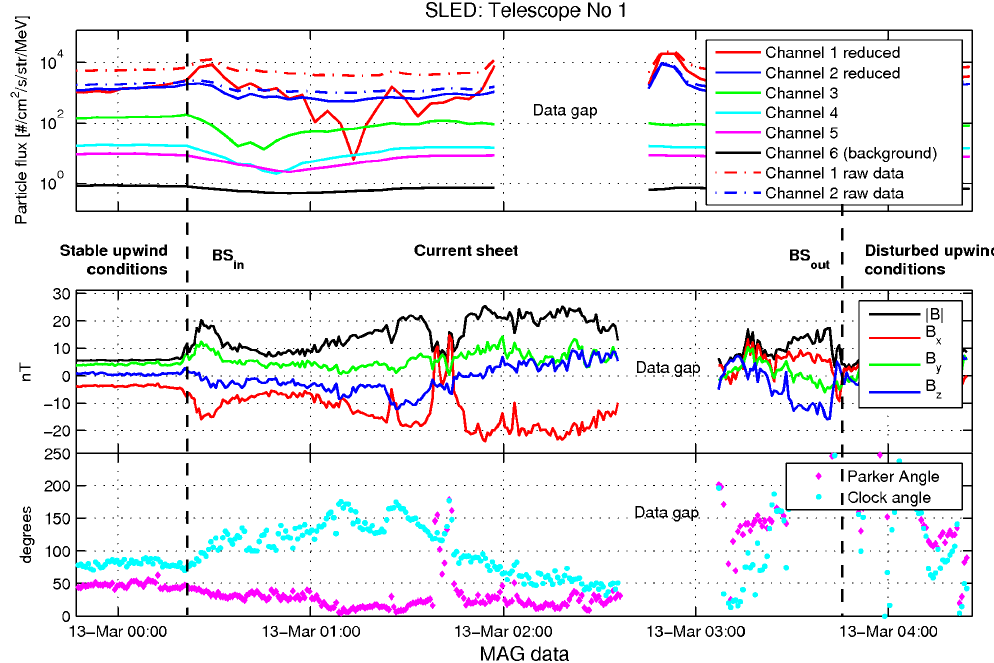
Fig. 2. Measurements made along the circular orbit of Phobos-2 on 13 March 1989. Top: SLED/Phobos-2 count rates in Te1 in six energy channels. The energy ranges and the measured particles of Te1 are the following (cf. Table 1): channel 1 (34–51keV, ions and electrons), channel 2 (51–202keV, ions and electrons), channel 3 (202–609keV, ions and electrons), channel 4 (0.6–3.2MeV, ions), channel 5 (3.2– 4.5MeV ions), channel 6 ( > 30MeV ions). The dashed and dotted lines show the raw data in channels 1 and 2. The solid lines show complementary data when the electron background has been removed from channels 1 and 2 (see the Appendix). No significant background was present in the higher energy channels. Middle: the corresponding magnetic field data recorded by MAGMA/ Phobos-2 are given in MSO coordinates. Bottom: the spiral angle, labelled as “Parker Angle”, and the clock angle. The two vertical lines show the crossings of the bow shock: Phobos-2 crossed the bow shock (BS IN ) and entered the magnetosheath at around 00:30UT and came back to the solar wind (BS OUT ) at around 03:40 UT. Note that the upstream conditions changed at around 01:40UT.